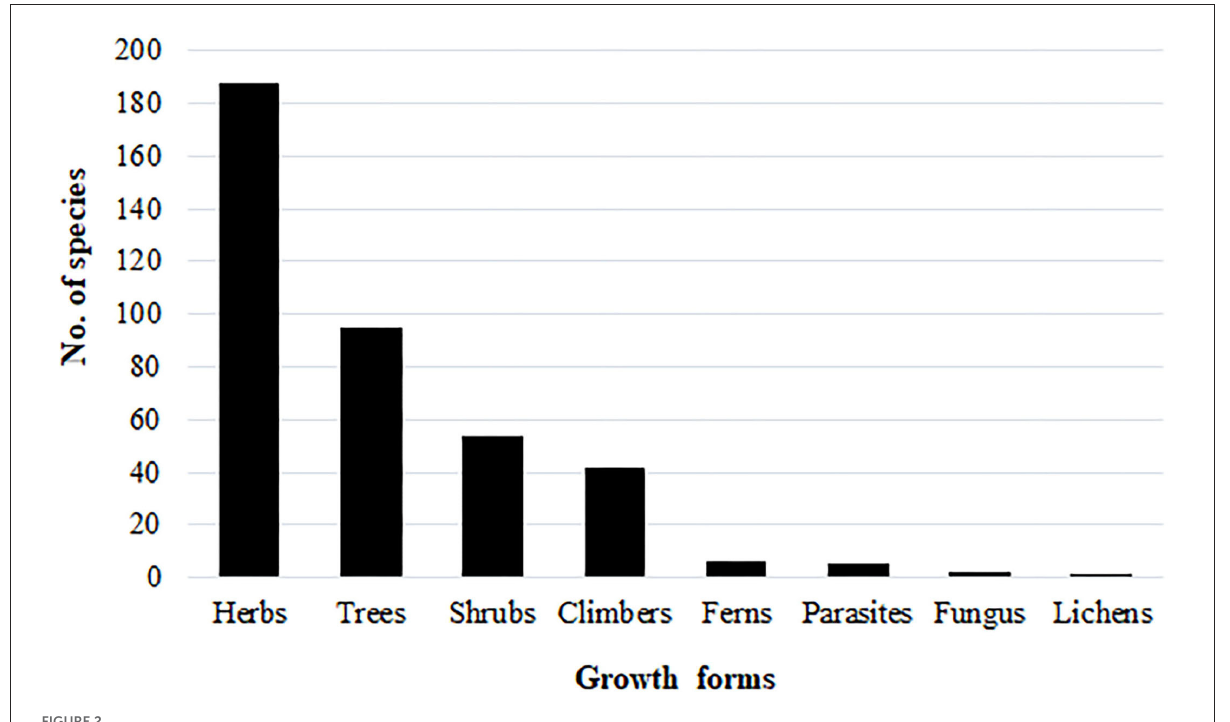
FIGURE2 Species distribution according to plant growth